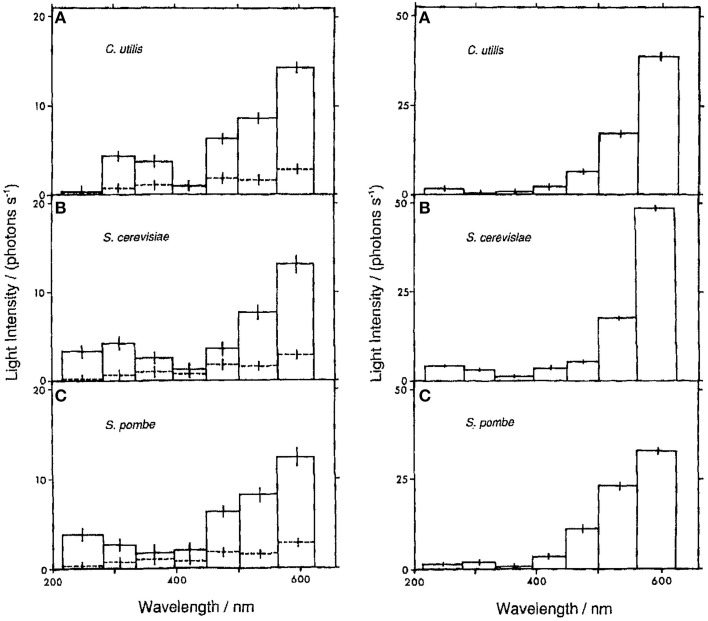
UPE spectra of oxygenated suspension cultures of C. utilis (A), S. cerevisiae (B), S. pombe (C) at 33°C (solid lines). Left, growing (exponential phase) cultures; right, stationary phase cultures. Dotted lines, UPE of the medium (from Tilbury and Quickenden, 1992). Spectra of stationary phase UPE (right column) correspond to ROS recombination (Tarusov et al, 1967; Boveris et al., 1981). Spectra of exponential phase UPE (left column) have two components: (1) visible (corresponds to ROS recombination), and (2) UV (unknown mechanism, corresponds to UPE spectra shown in Troitskii et al. (1961), Gurwitsch et al. (1965), and to spectra of MGE (Frank, 1929).